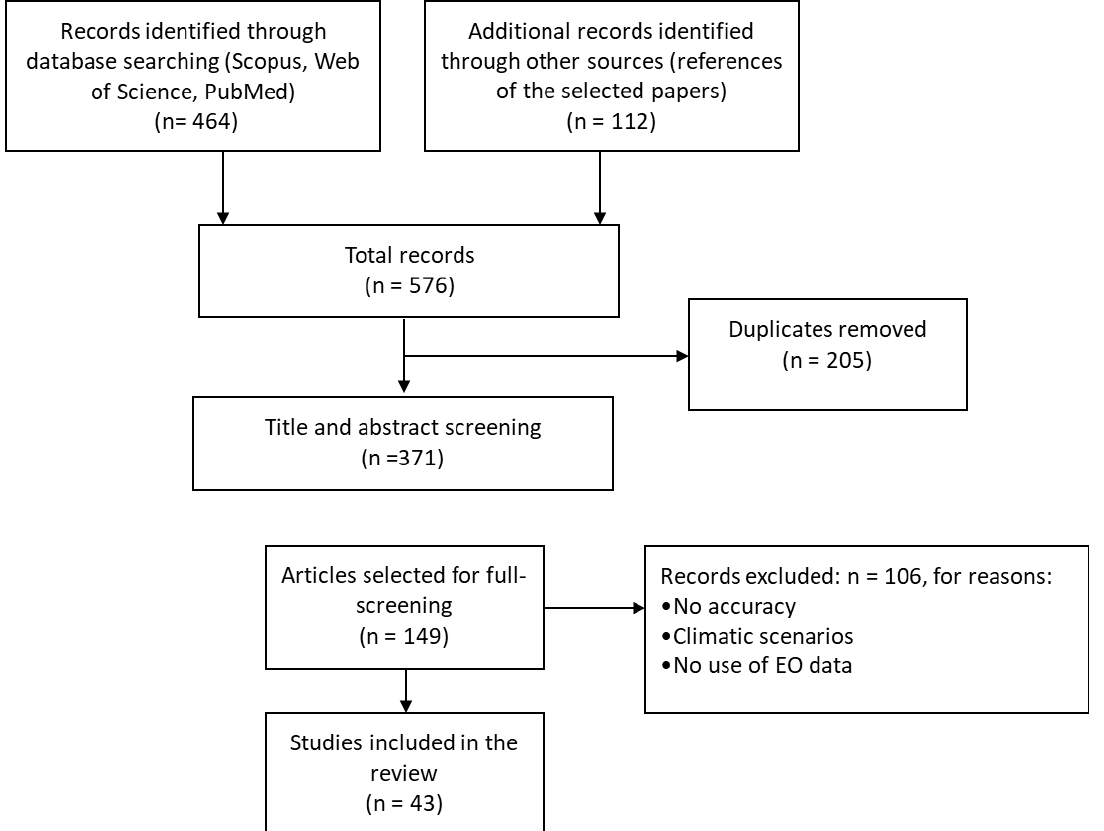
Figure 1. Flow Diagram of article selection (inclusion/exclusion)